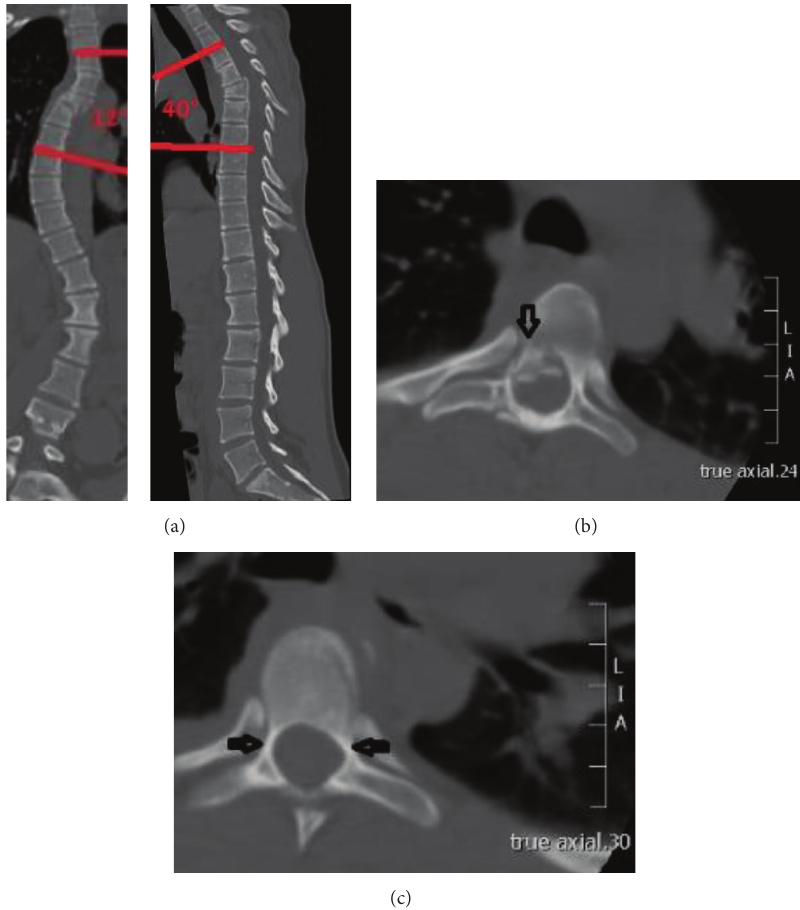
Figure 1: (a) CT scans showing the preexisting scoliosis and the fracture of T5. Cobb angle (T3–7): 12 ∘ , kyphosis angle (T3–7): 40 ∘ . (b) CT scan showing the fragment narrowing the spinal canal. (c) CT scan showing the small pedicles (blind on the right side, 2.5 mm on the